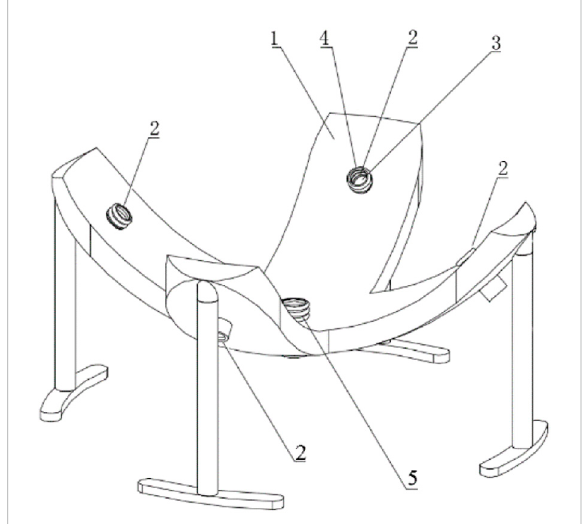
Sketch of the spectrometer. 1: bracket; 2: LED-mounting groove; 3: light source; 4: annular silicone buffer washer; and 5: integrating sphere mounting